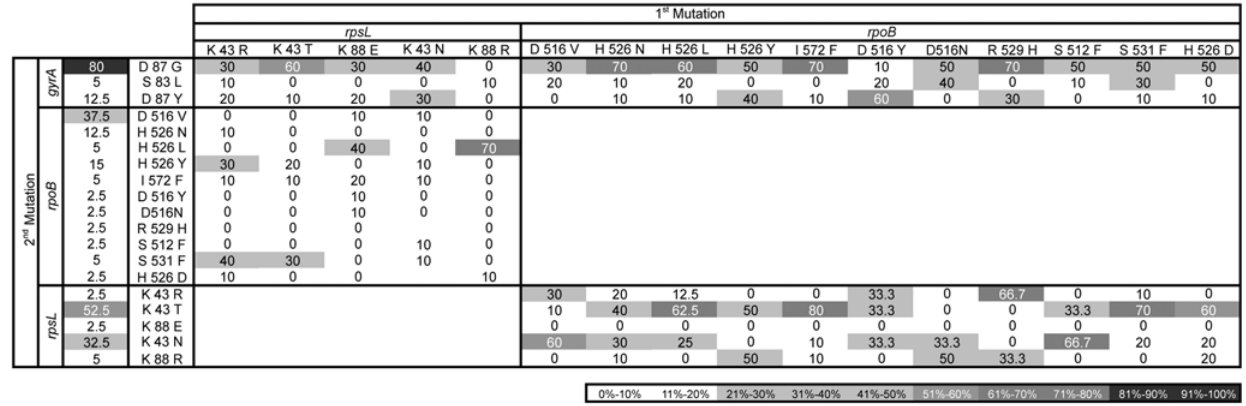
Figure 4. Mutational spectrum and frequency of spontaneous double resistance mutations. Given the genetic background of the first mutation (column) the frequency of the second mutation (raw) appears as percentage in grey scale gradient. For a given background the percentage of mutations in the second locus adds up to 100%, in most cases, except when the second mutation occurred in a different gene. The percentage of the occurrence of each mutation in a wild-type background is also shown in the third